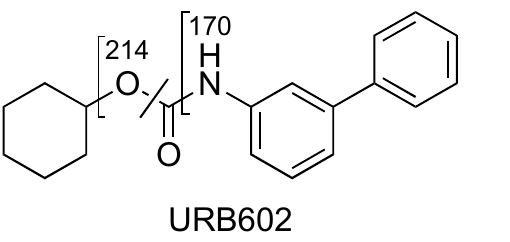
Figure 10 . Product ion scan of URB937 compound obtained by HRMS.